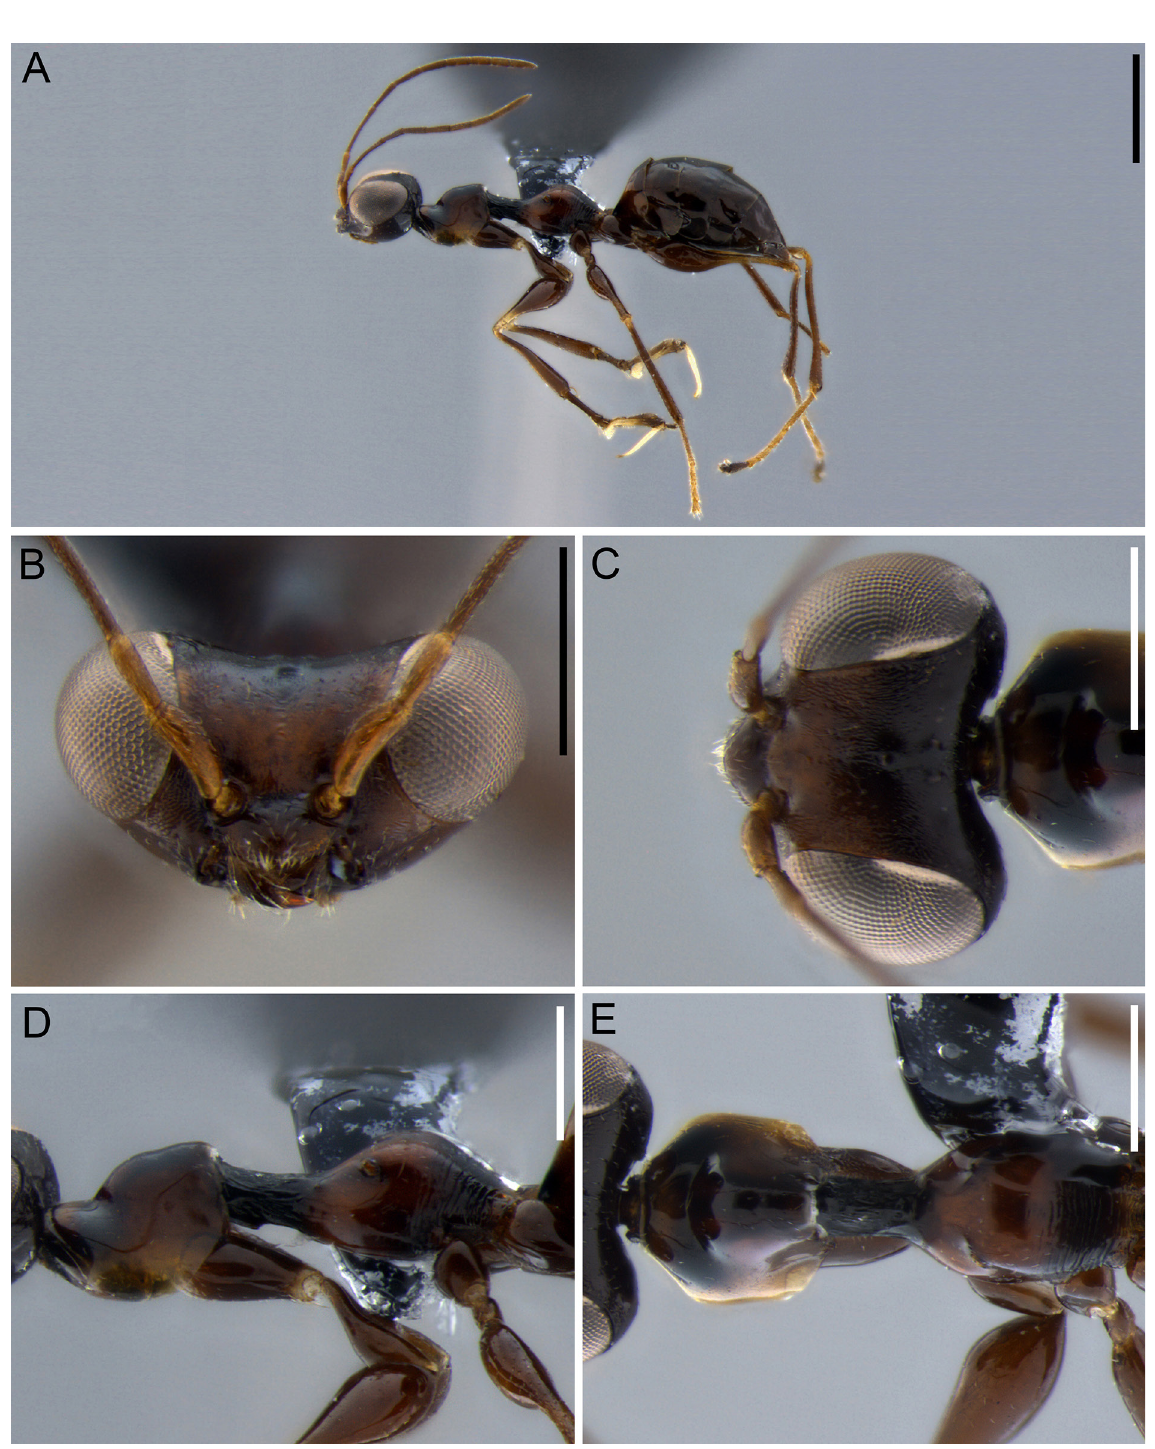
Fig. 4. Pareucamptonyx kumagaiae Martins sp. nov., holotype, ♀ (UFMG). A . Habitus, lateral view. B . Head, frontal view. C . Head, dorsal view. D . Mesosoma, lateral view. E . Mesosoma, dorsal view. Scale bars =